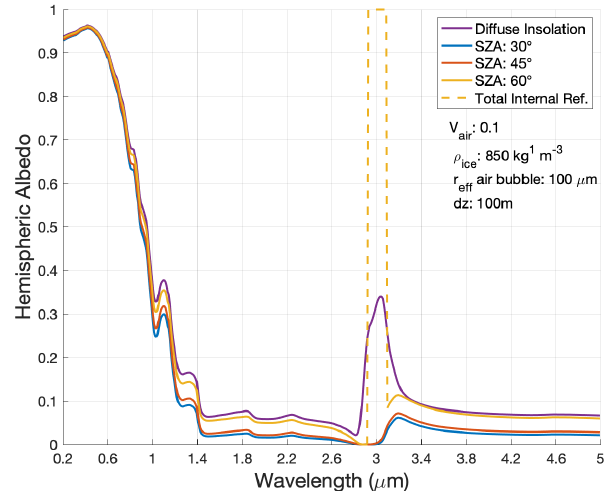
Figure 2. Spectral albedo with varying SZA. Each line indicates the spectral albedo simulated by SNICAR-ADv4 with a different SZA. The purple line shows the spectral albedo for the ice layer under diffuse light conditions, and the dashed line indicates where total internal reflection occurs on the smooth ice